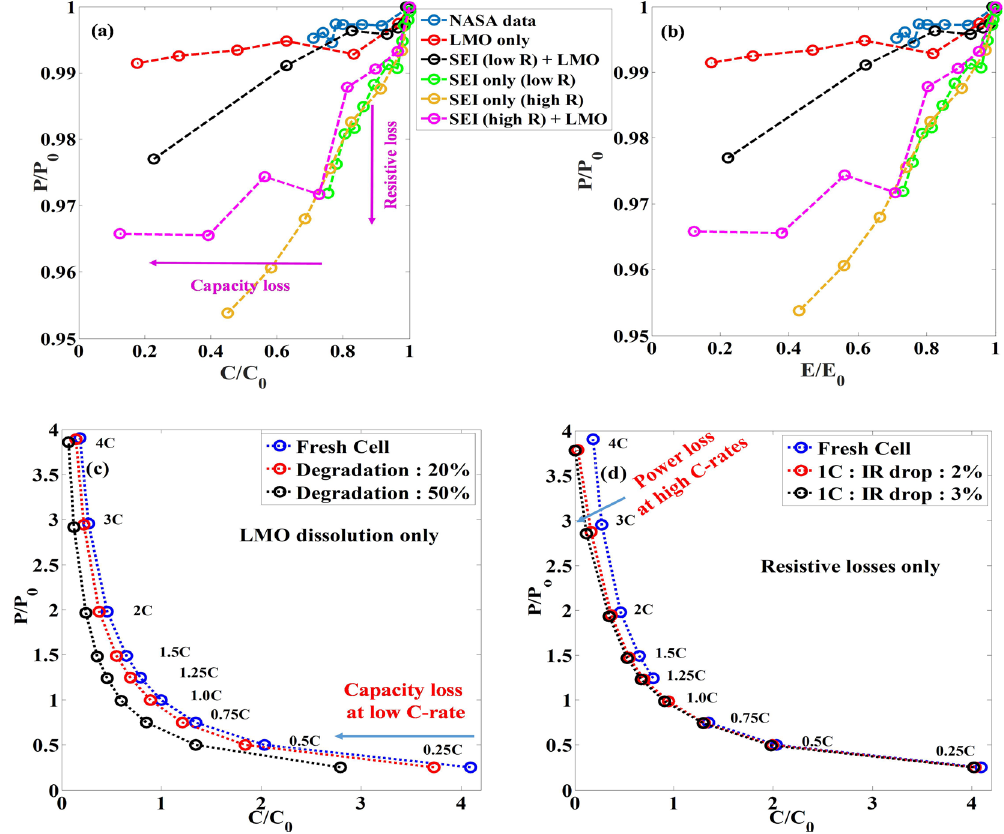
Figure 6. Representation of degradation characteristics of ageing cells in the power-energy-capacity space. ( a ) The normalized power as a function of the normalized time for systems with different degradation mechanisms. ( b ) The normalized power as a function of the normalized energy for systems with different degradation mechanisms. Plot showing the normalized power as a function of the normalized time for different degraded states at different C-rates for different combinations of degradation mechanisms ( c ) LMO dissolution only and ( d ) Anode SEI only (with different resistance values). Normalization is with respect to the corresponding value at 1C of the fresh